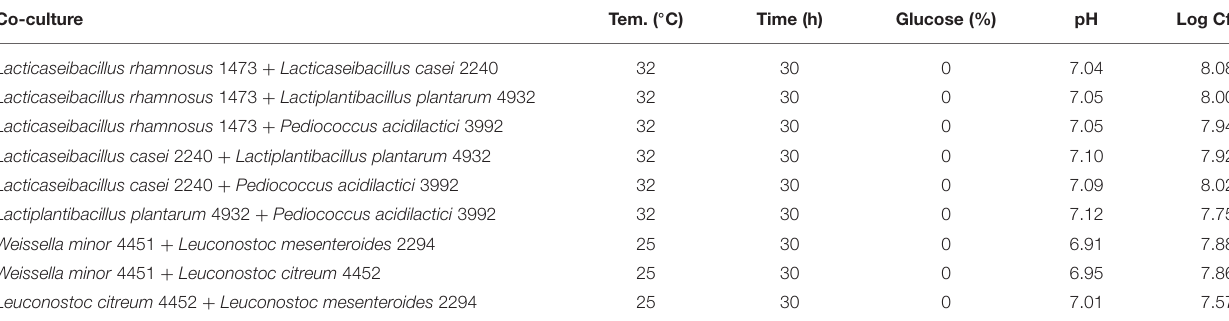
TABLE 6 | Condition of fermentation with co-cultures in samples with seeds. Co-culture